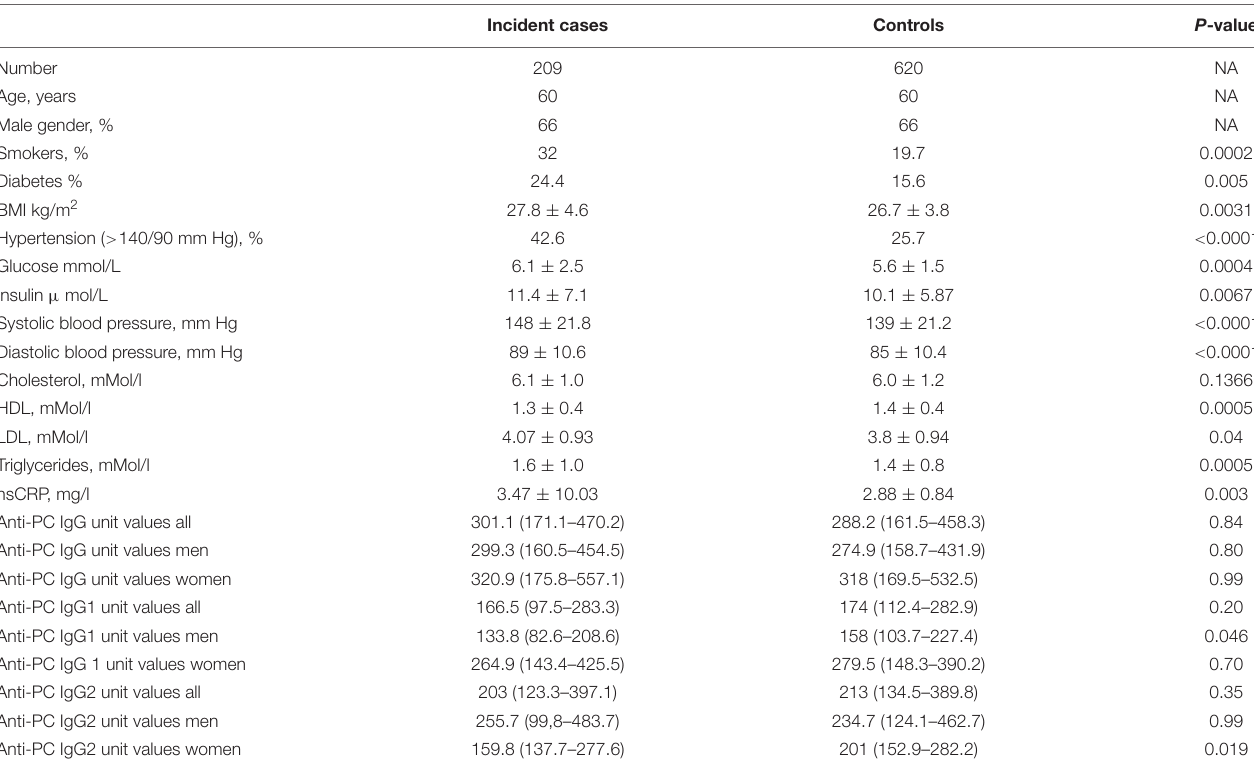
TABLE 1 | Baseline characteristics among incident cardiovascular disease (CVD) cases and matched